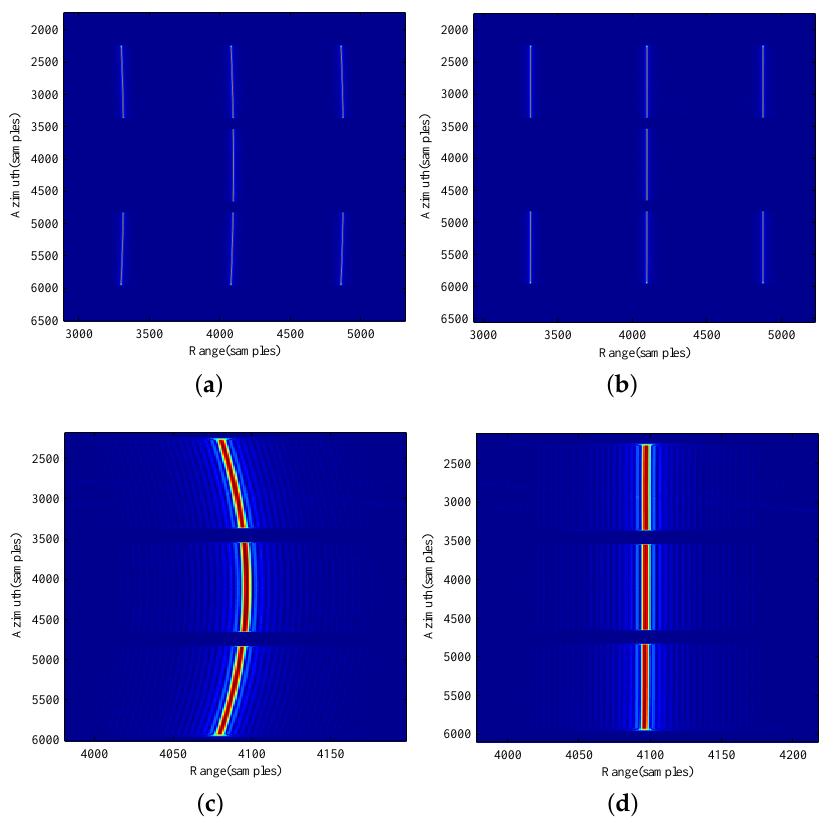
Figure 7. Effect of the higher-order range cell migration correction (RCMC). ( a ) Seven targets before higher-order RCMC; ( b ) Seven targets after higher-order RCMC; ( c ) Detailed figure of the three targets in the 4097 range bin before higher-order RCMC; ( d ) Detailed figure of the three targets in the 4097 range bin after higher-order RCMC.